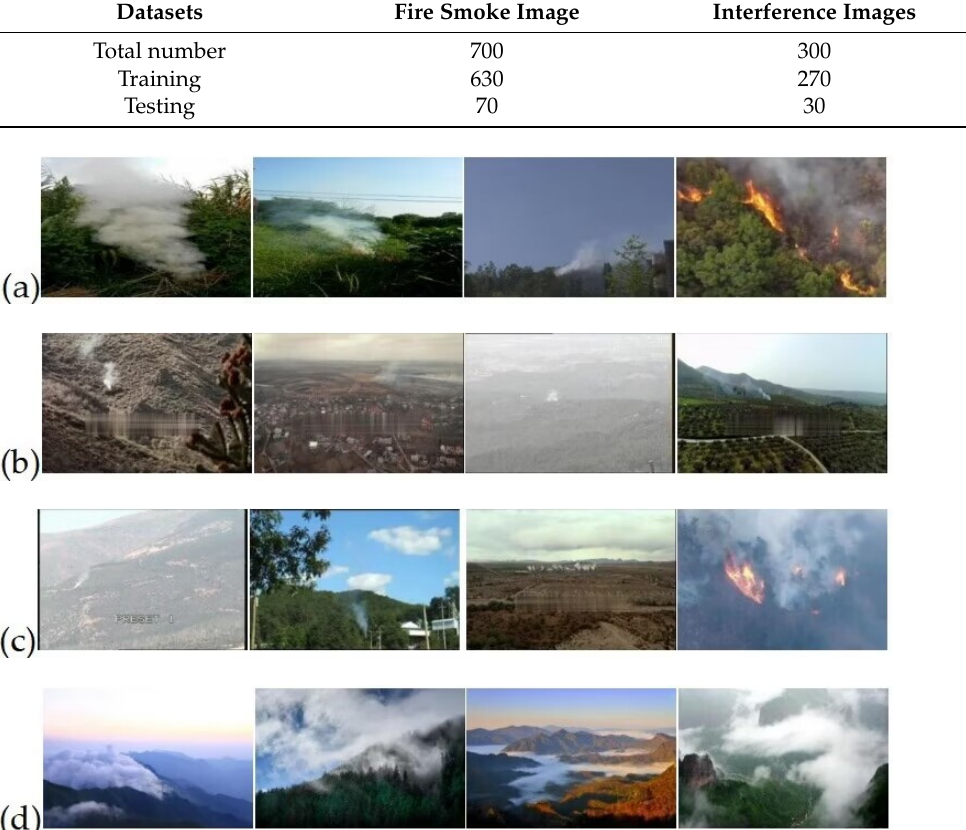
Figure 1. Example images from the datasets, which include white smoke and black smoke images, thick smoke and thin smoke images, small smoke images, smoke images with clouds, and interference images. ( a – c ) contain different types of smoke dataset in the field, and ( d ) show cloud interference dataset.